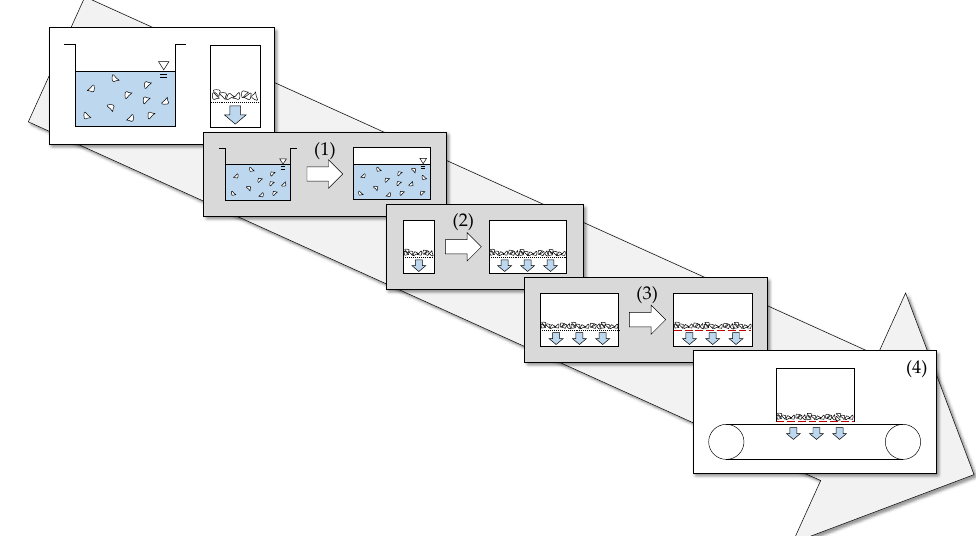
Figure 4. Transfer of the conventional process route to the integrated laboratory system. In a first step, the batch vessel is replaced by a process chamber (1). Subsequently, the scale of the filtration process is enlarged (2) and tests are carried out with a filter cloth (3). Finally, the transfer to the laboratory plant takes place